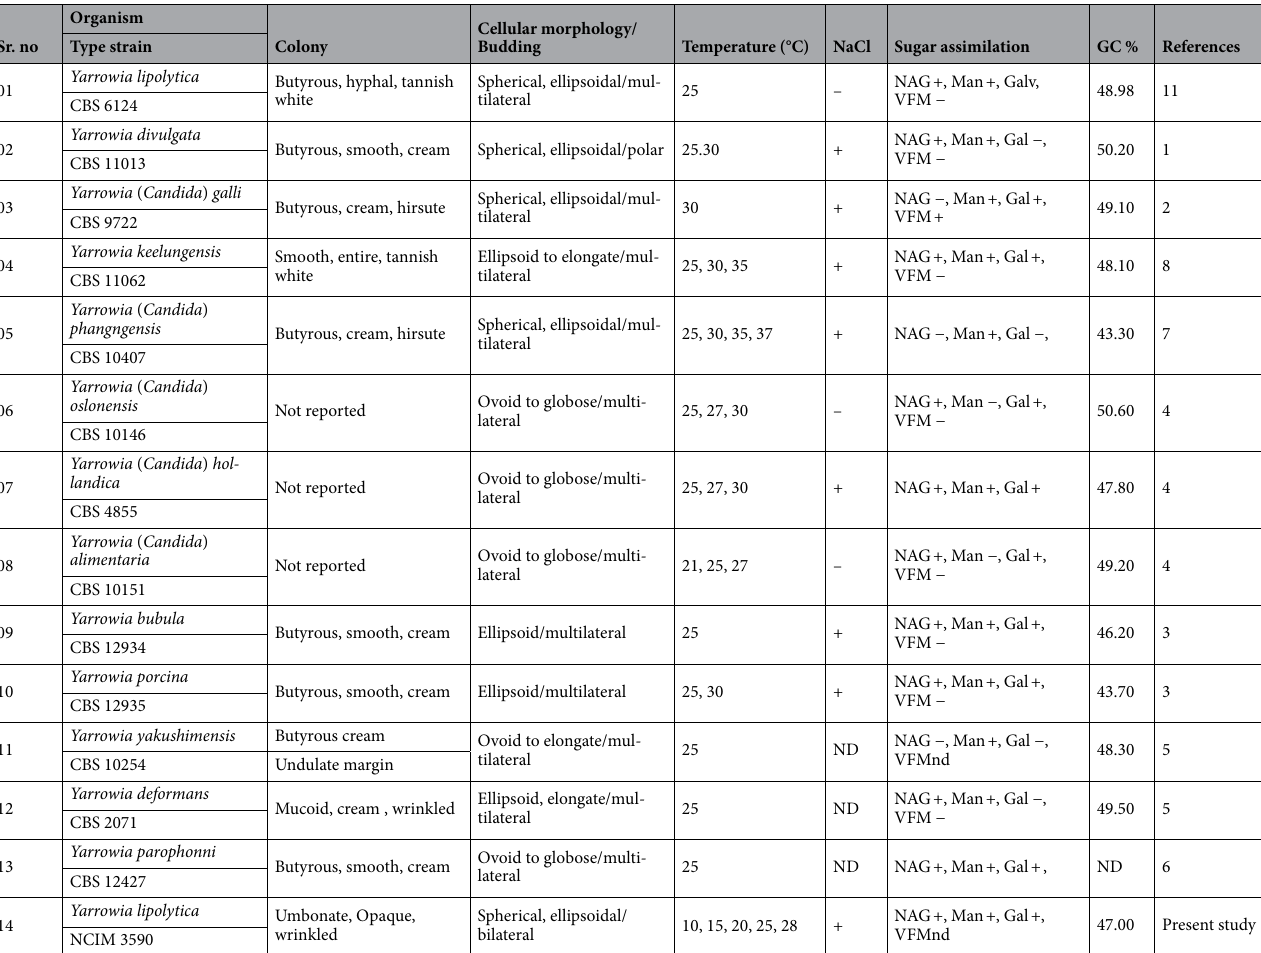
Table 4. Comparison of NCIM 3590 with different Yarrowia sp. (+) Positive, (−) Negative, v Variable, ND not determined, NAG N -Acetyl-d-glucosamine, Man d-Mannitol, Gal d-galactose, VFM vitamin free medium; GC%—https ://www.ncbi.nlm.nih.gov/genom e/brows e#!/eukar yotes /yarro wia. CBS Central Bureau voorSchimmelcultures, Utrecht, The Netherlands, NCIM National Collection of Industrial Microorganisms, Pune,